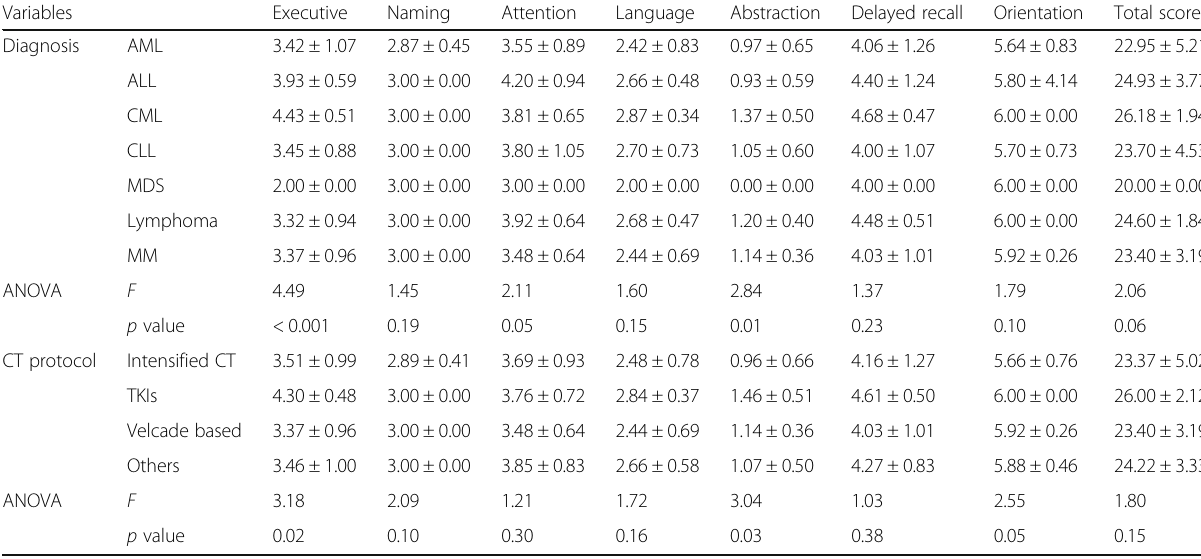
Table 5 Impact of patient diagnosis and types of chemotherapy on the score of each component of cognitive functions